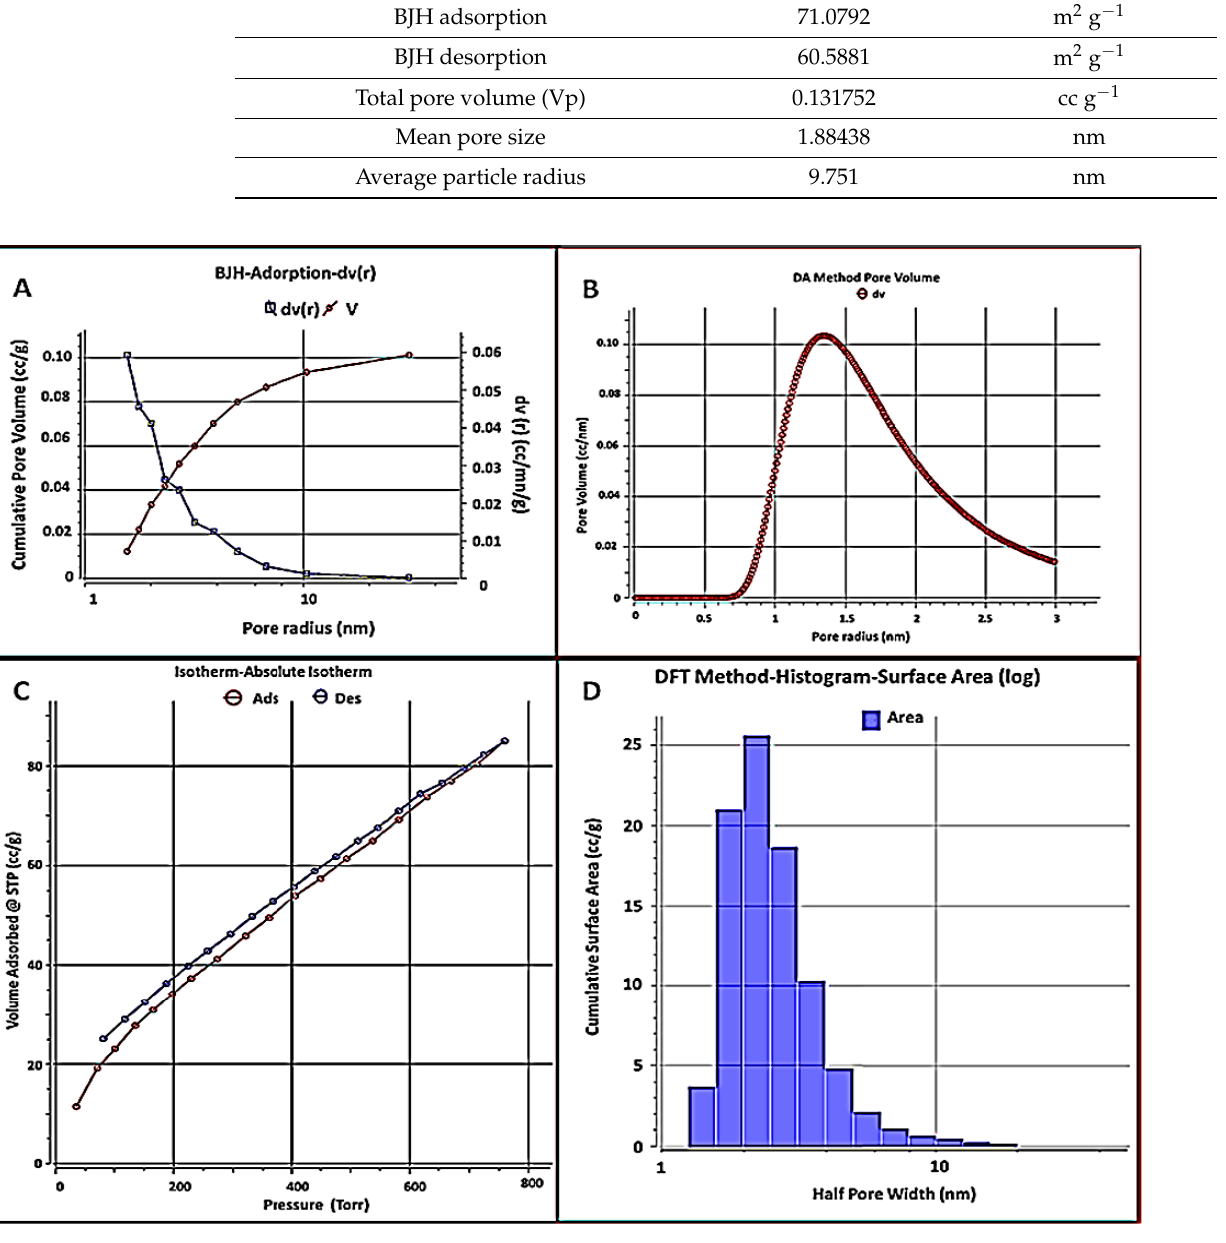
Figure 5. BJH – adsorption – dV(r) at 77 K for A. platensis nanoparticles, BJH-Adsorption-dv(r) ( A ), Figure 5. BJH–adsorption–dV(r) at 77 K for A. platensis nanoparticles, BJH-Adsorption-dv(r) ( A ), DA DA method pore volume ( B ), nitrogen adsorption – desorption isotherms ( C ) and DFT method his- method pore volume ( B ), nitrogen adsorption–desorption isotherms ( C ) and DFT method histogram– togram – surface area ( D ). surface area ( D